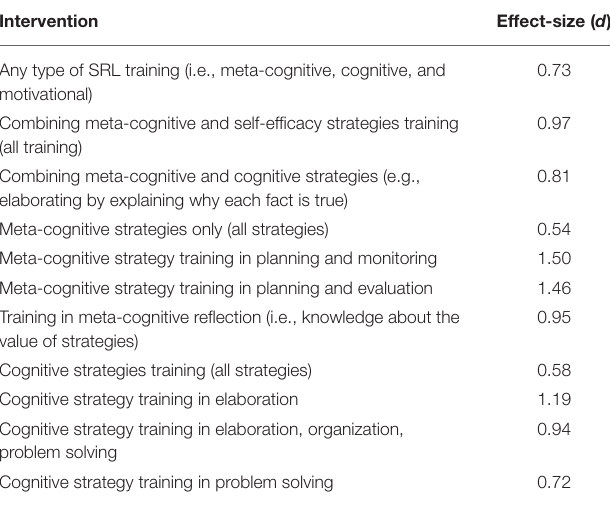
TABLE 2 | Summary of intervention-type and effect-size (Dignath et al., 2008). Intervention Effect-size ( d